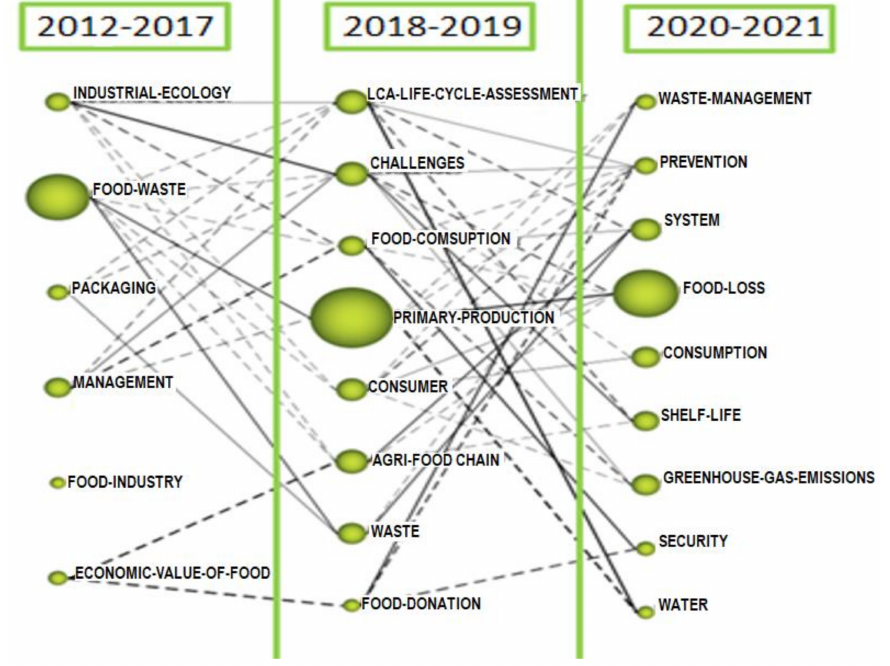
Figure 8. Thematic evolution